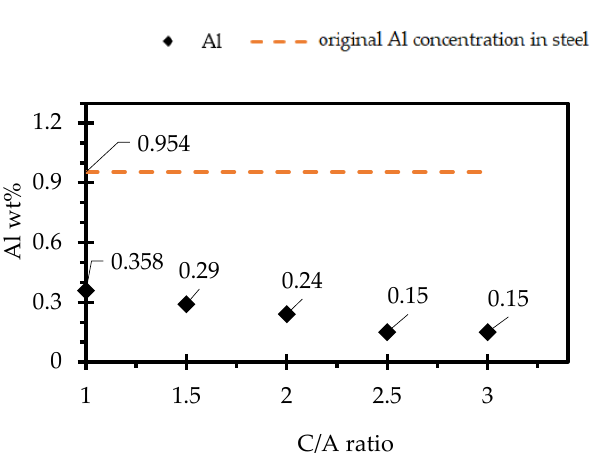
Figure 18. Change in total aluminium content of steel depending on C/A ratio for the 20 min interaction time.